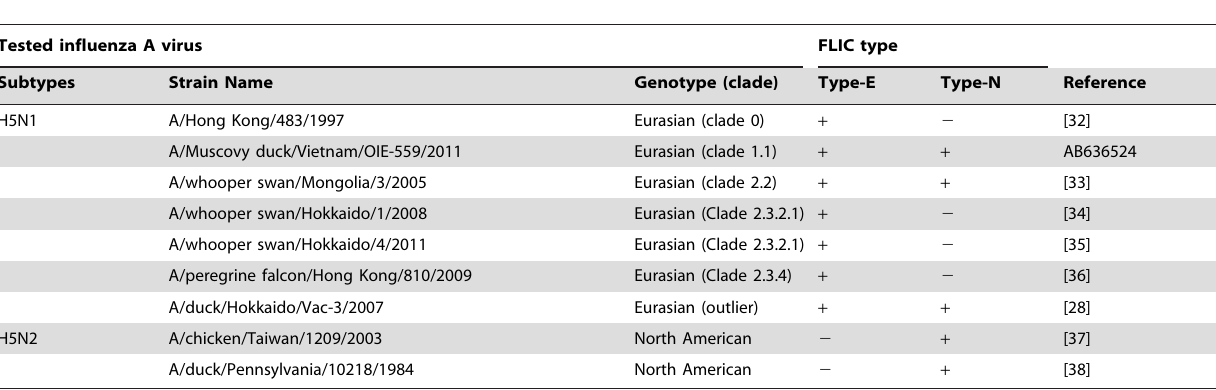
Table 4. Specificities of H5 FLIC for H5 subtypes of influenza A